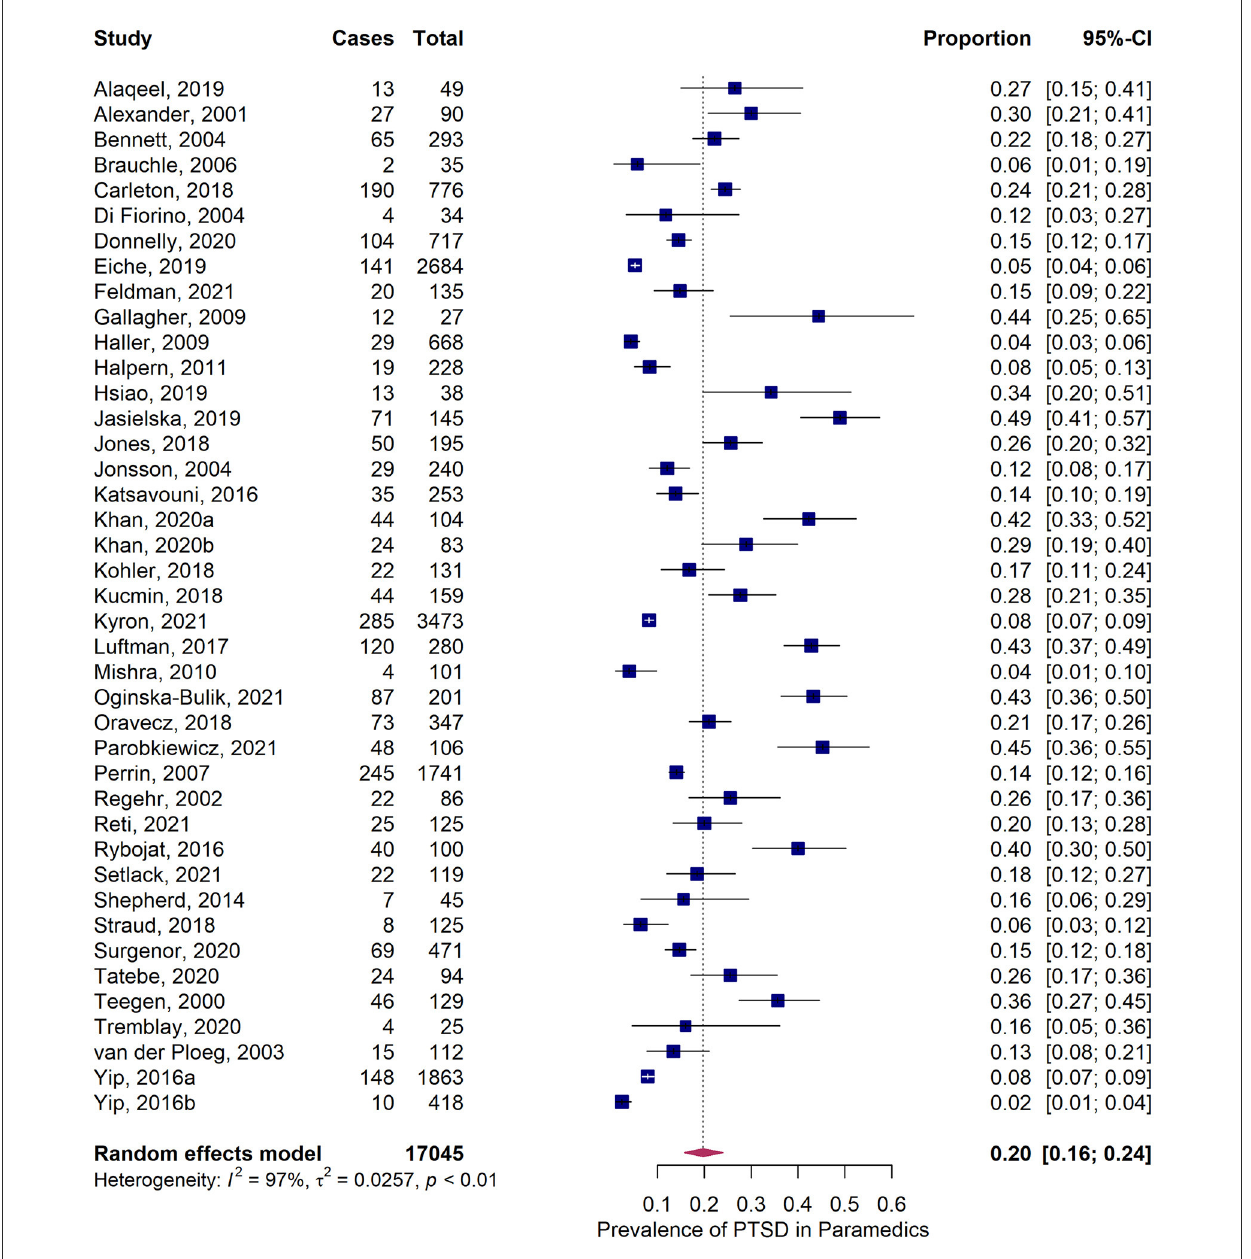
FIGURE3 Forest plot of 12-month prevalence of posttraumatic stress disorder (PTSD) in paramedics.